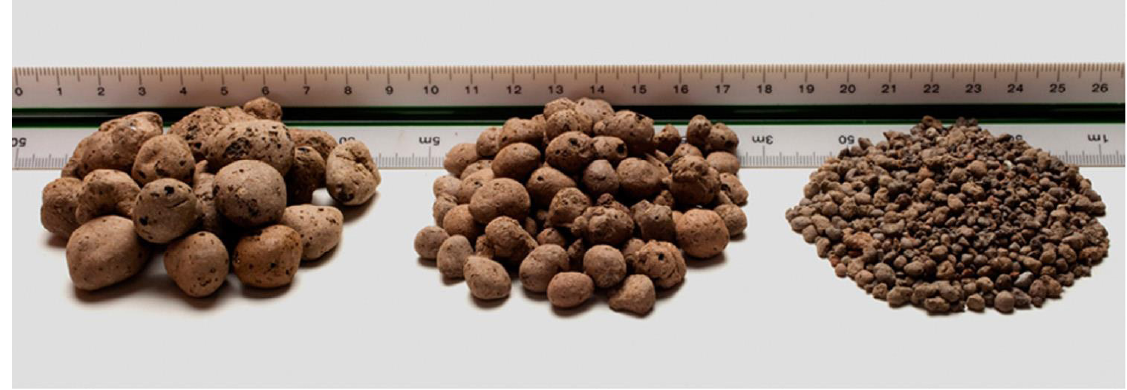
Figure 1: Lightweight aggregates differing in their diameter (from left to right: 8–16 mm, 4–8 mm, 2–4 mm) (Rashad,